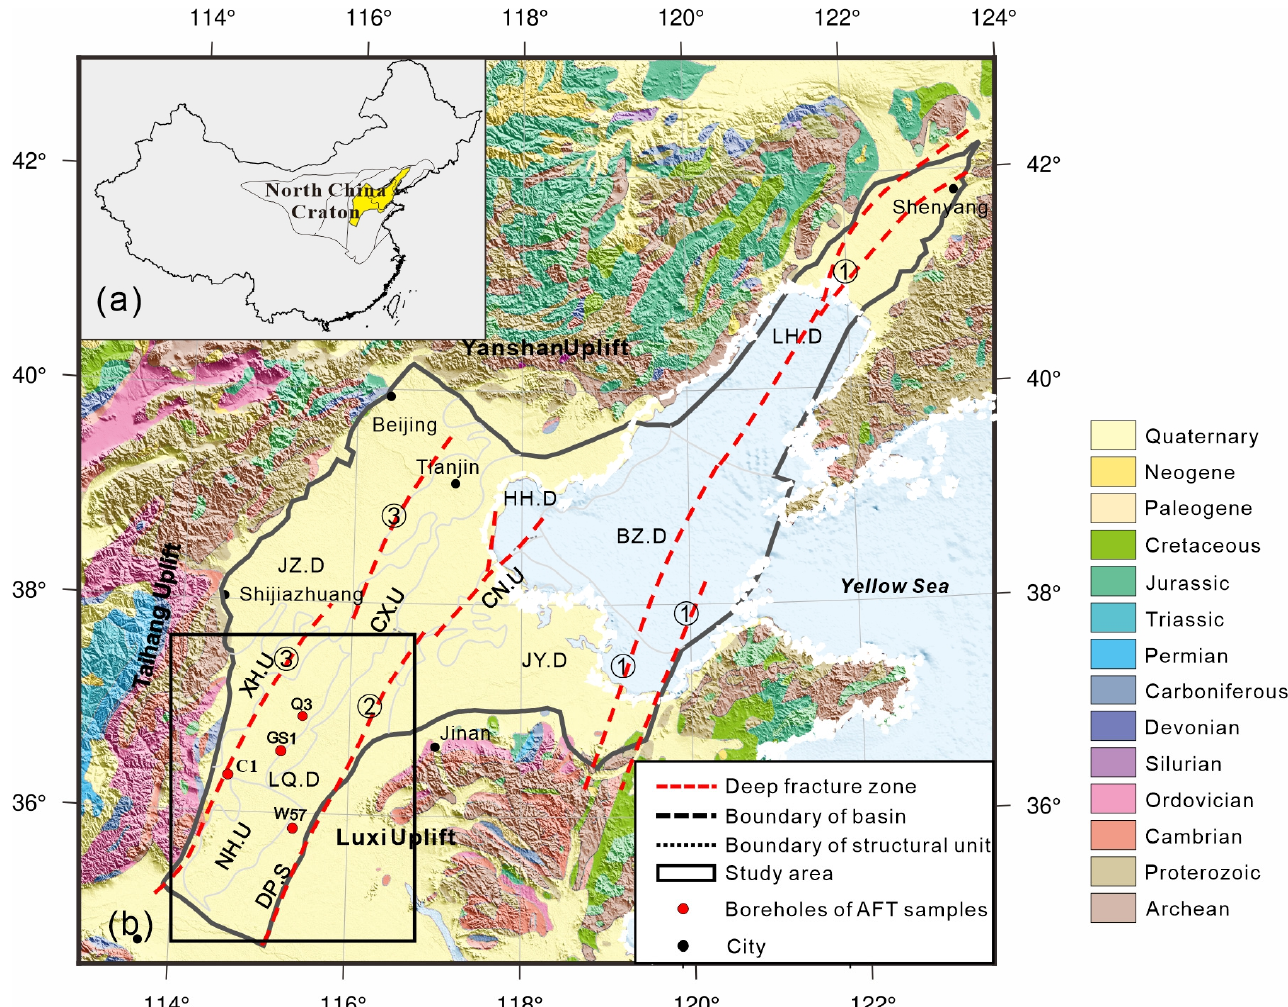
Figure 1. ( a ) Location of the North China Craton and the Bohai Bay Basin (BBB), yellow color. ( b ) Geological map of the Bohai Bay Basin (after Xu et al., 2020 [20]). Uplifts: Cangxian Uplift (CX.U), Chengning Uplift (CN.U), Neihuang Uplift (NH.U), Xingheng Uplift (XH.U); Depressions: Bozhong Depression (BZ.D), Huanghua Depression (HH.D), Jiyang Depression (JY.D), Jizhong Depression (JZ.D), Liaohe Depression (LH.D), Linqing Depression (LQ.D); Faults: ① northern part of the Tanlu Deep Fracture Zone; ② Lanliao Deep Fracture Zone; ③ Shulu–Handan Deep Fracture Zone.